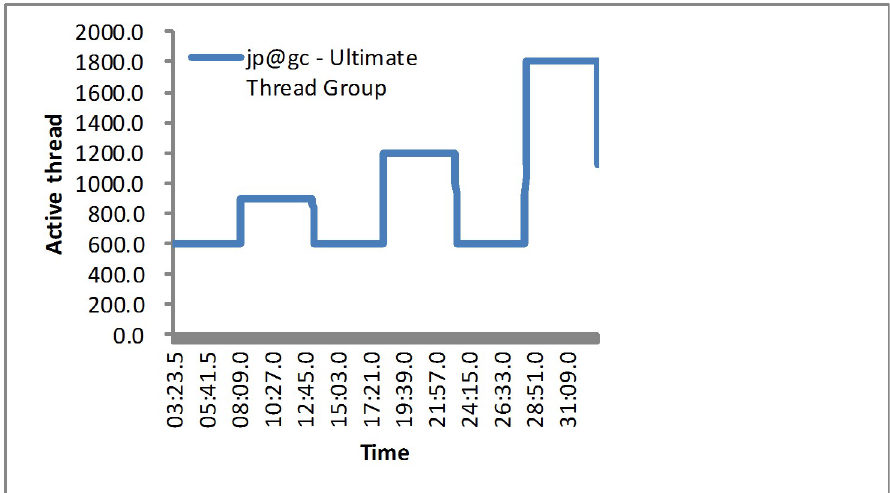
Fig 3. Active threads in the first